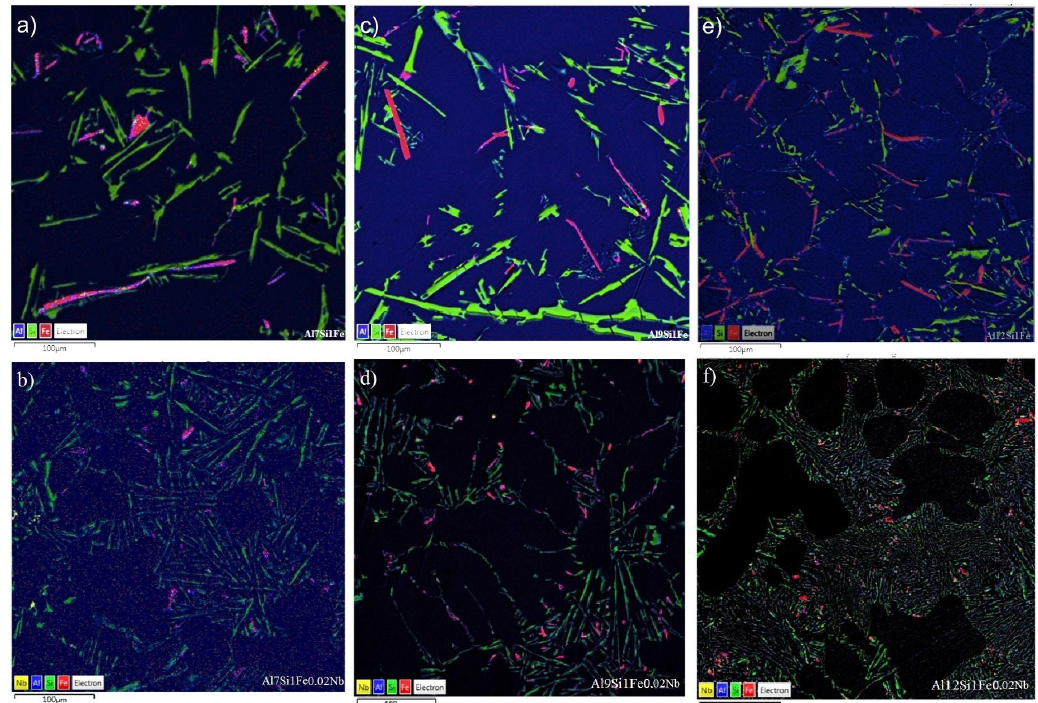
Figure 11. SEM-EDS images showing the microstructure of the alloys containing 7 Wt.% Si (a, b), 9 Wt.% Si (c, d) and 12 Wt.% Si (e, f); Without NbB addition (a, c and e) and with 0.02 Wt.% Nb and B according to stoichiometric calculation (b, d, and